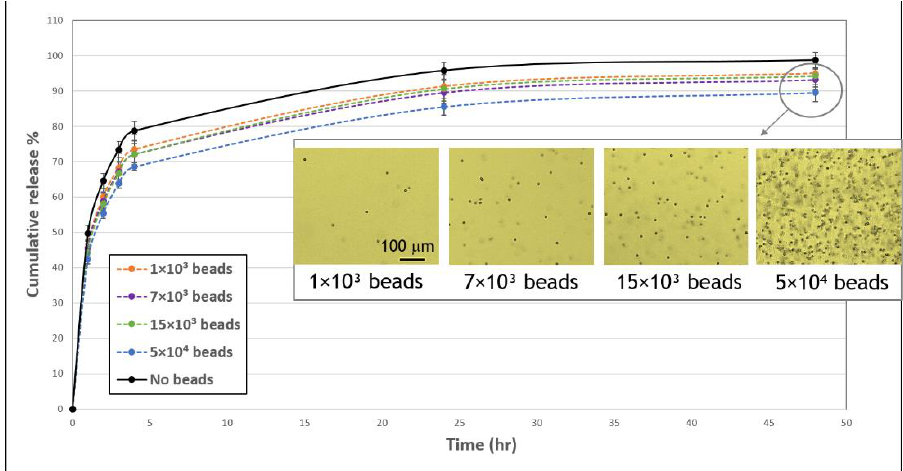
Figure 7. Influence of beads on the cumulative release profile of FD 250 kDa from fibrin gels. FD-loaded gels were embedded with 1 × 10 3 (orange, dashed line), 7 × 10 3 (purple, dashed line), 15 × 10 3 (green, dashed line), or 5 × 10 4 (blue, dashed line) or without (black, continuous line) polystyrene beads (10.2 µ m) and FD release was monitored over the subsequent 48-h period. A statistically significant difference in FD release from gels with 7 × 10 3 , 15 × 10 3 , and 5 × 10 4 versus without beads was noted throughout the observation period ( p < 0.05). The values represent the mean ± SD. The number of replicates is N = 9, 11, 10, 11 and 5 for: no beads, 1 × 10 3 , 7 × 10 3 , and 15 × 10 3 , 5 × 10 4 beads, respectively. Insert shows images of bead-embedded gels after 48 h. Scale bar is 100 µ m.